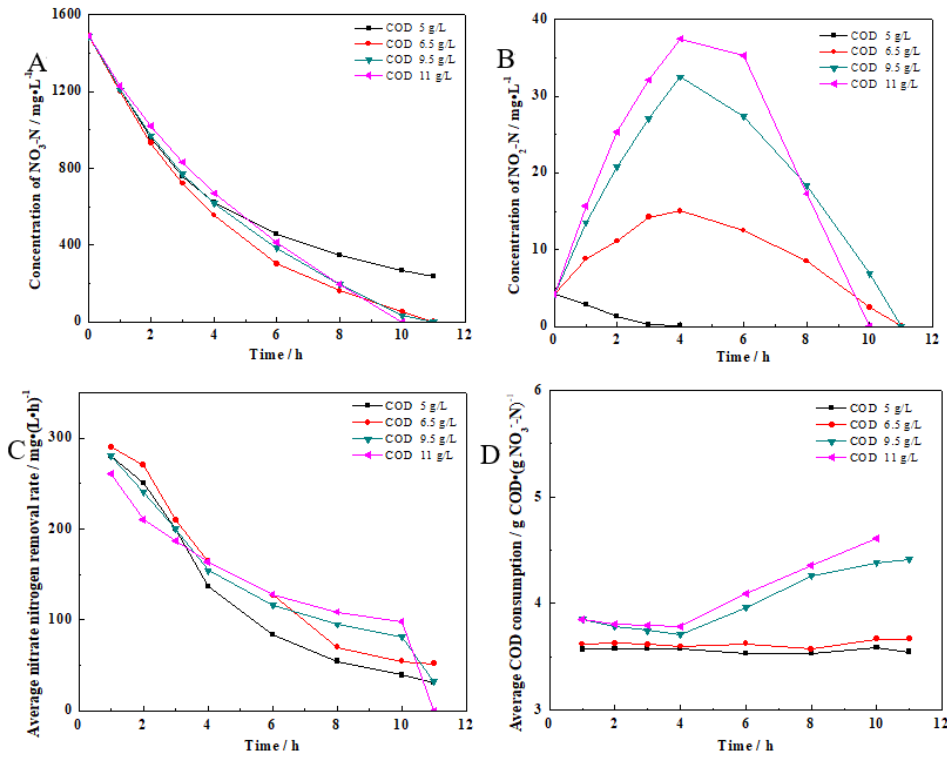
Figure 2. Changes of nitrate nitrogen concentration ( A ), nitrite nitrogen concentration ( B ), average nitrate nitrogen removal rate ( C ) and average COD consumption and COD ( D ) under different COD concentrations.